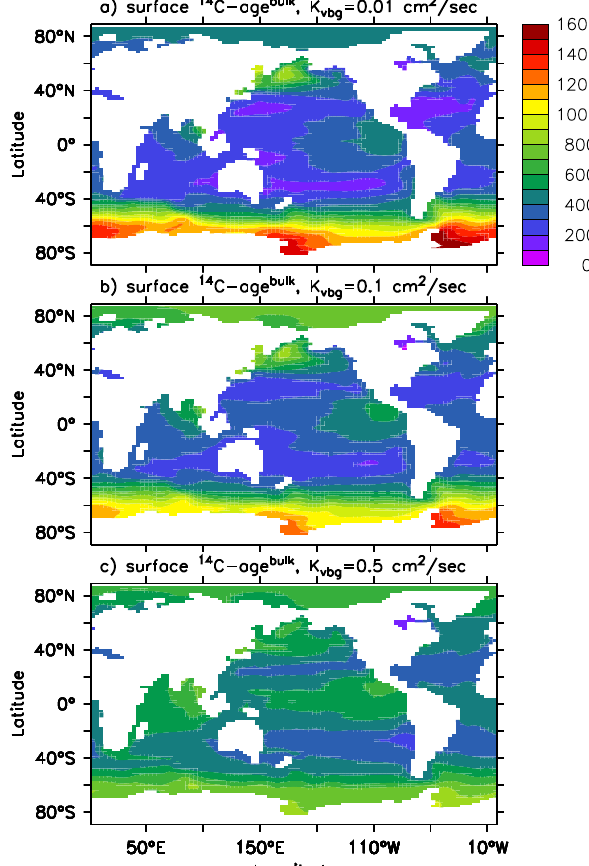
Figure 12. Surface bulk 14 C-age in the UVIC model for three differ- ent K vbg values. (a) K vbg = 0 . 01cm 2 s − 1 , (b) K vbg = 0 . 1cm 2 s − 1 and (c) K vbg = 0 . 5cm 2 s − 1